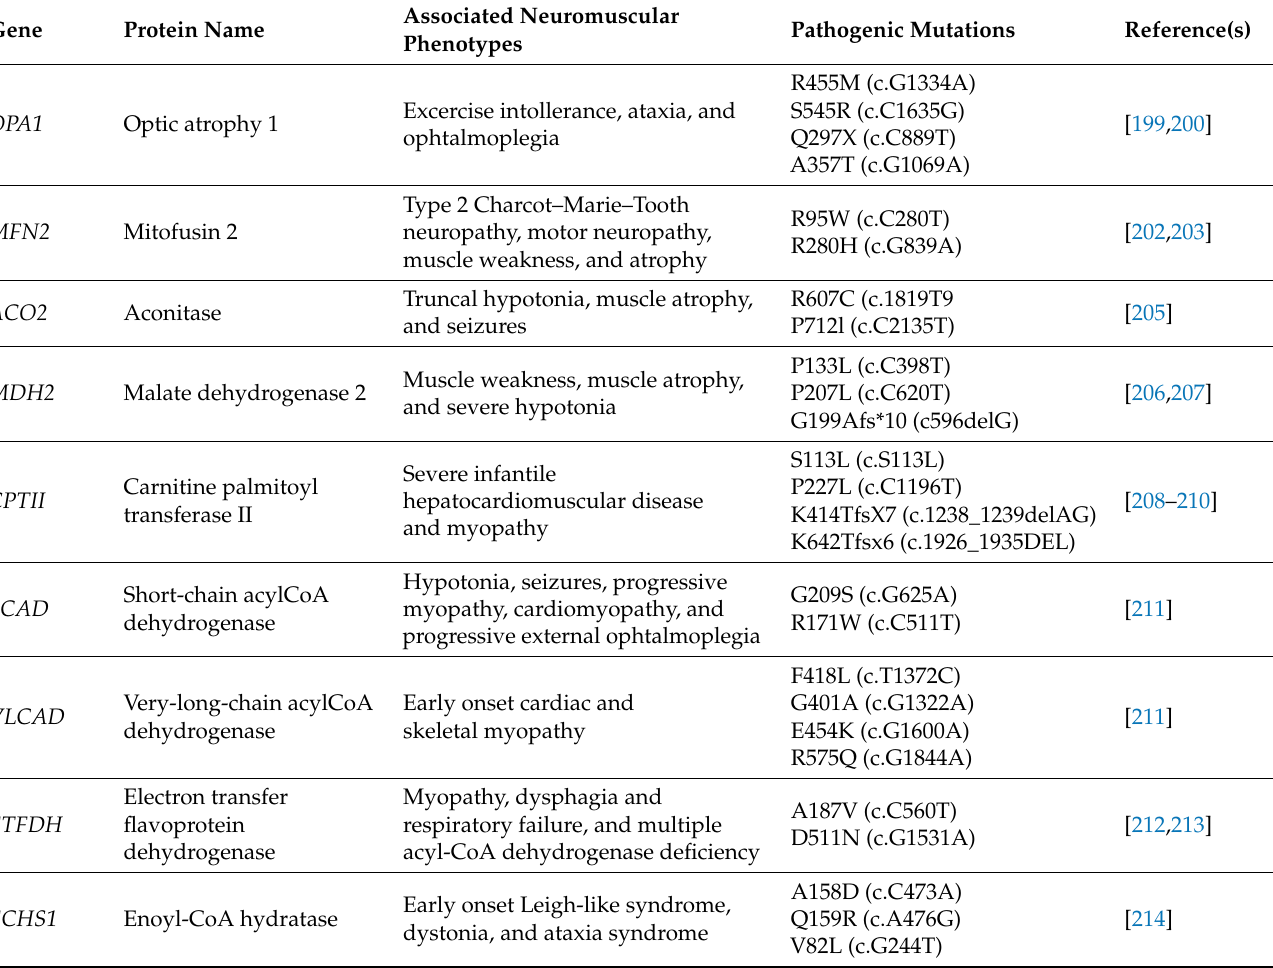
Table 2. Impaired mitochondrial enzymes associated with neuromuscular phenotypes. Their amino acids and nucleotide mutations are also reported. For the functions of the listed proteins see Figure